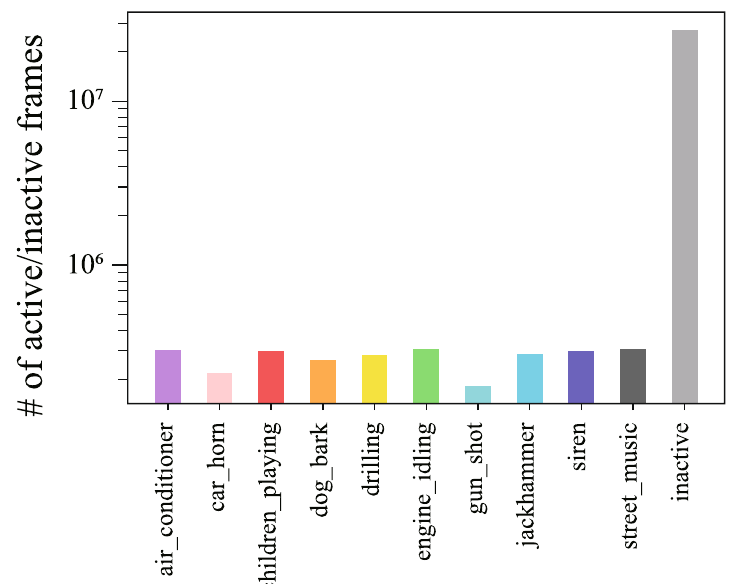
Fig. 4 Numbers of active and inactive frames for each